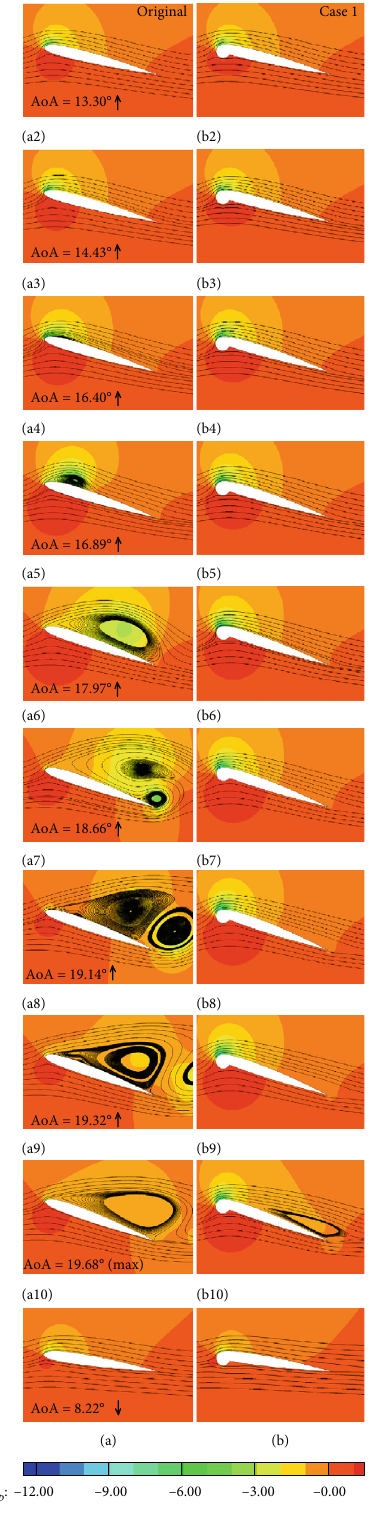
Figure 14: Streamlines and pressure coe ffi cient contours of the original airfoil and the ILE airfoil in Case 1 at di ff erent angles of